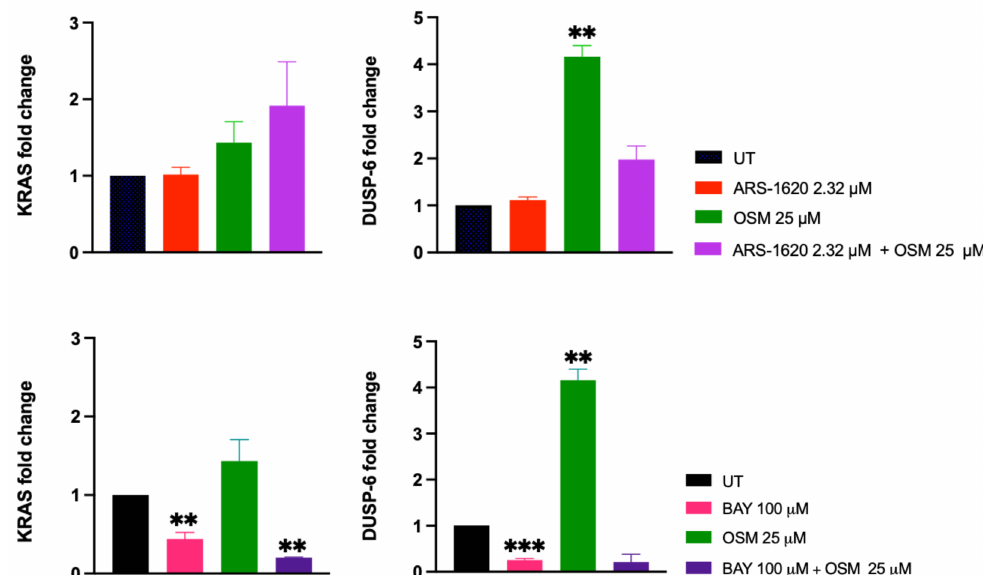
Figure 7. Gene expression analysis of synergistic drug combinations. The top two panels show KRAS and DUSP-6 expression levels upon treatment with ARS-1620, osimertinib, and combination at 24 h; similarly, the bottom two panels show KRAS and DUSP-6 expression levels upon treatment with BAY-293, osimertinib, and combination at 24 h. Treatment with osimertinib significantly in- creased DUSP-6 expression relative to the untreated control ( p < 0.01; **). There were no significant differences between any of the treatment conditions of KRAS expression levels for the ARS-1620 and osimertinib conditions. However, treatment with BAY-293 significantly decreased expression of DUSP-6 comparedto the untreated control ( p < 0.001; ***). Treatment with BAY-293, and BAY-293 combined with osimertinib, also significantly decreased the expression of KRAS compared to the untreated control, albeit to a lesser extent ( p < 0.01). These findings indicate BAY-293 inhibits H1792 proliferation through suppression of MAPK as measured by decreased DUSP-6, while osimertinib and ARS-1620 inhibit proliferation through mechanisms that need to be further elucidated. Created with